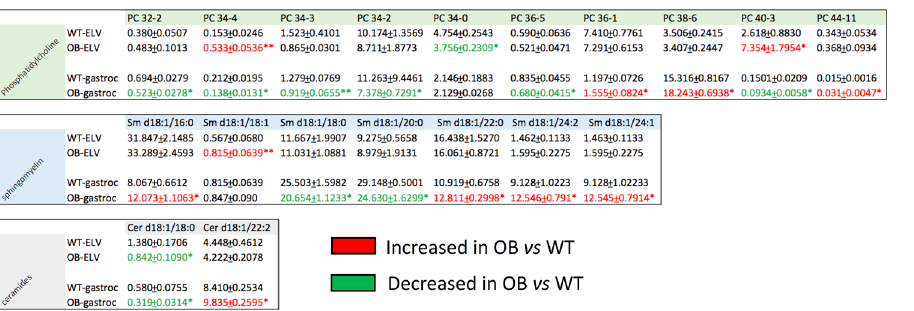
Figure 3. Impact of obesity on SkM-ELV lipid profile. ( A , B ) TEM images of Quad muscle from WT ( A ) or OB ( B ) mice. ( C ) Quantification of phospholipids, sphingolipids and cholesterol in Gast from WT and OB mice. ( D ) Quantification of Hmgcr mRNA in WT- and OB-Gast (* = p < 0.05, student t-test). ( E ) Quantification of phospholipids, sphingolipids and cholesterol in WT-ELVs and OB-ELVs released from Gast. ( F ) Lipids differentially concentrated in OB-ELVs or OB-GAST vs their respective WT. Data are expressed as % of total PC, or total SM or total Ceramides identified and quantified from the same concentration of starting material. Significant distributions are determined from student t -test (* = p < 0.05, ** = p < 0.01). red: increased vs control; green: decreased vs